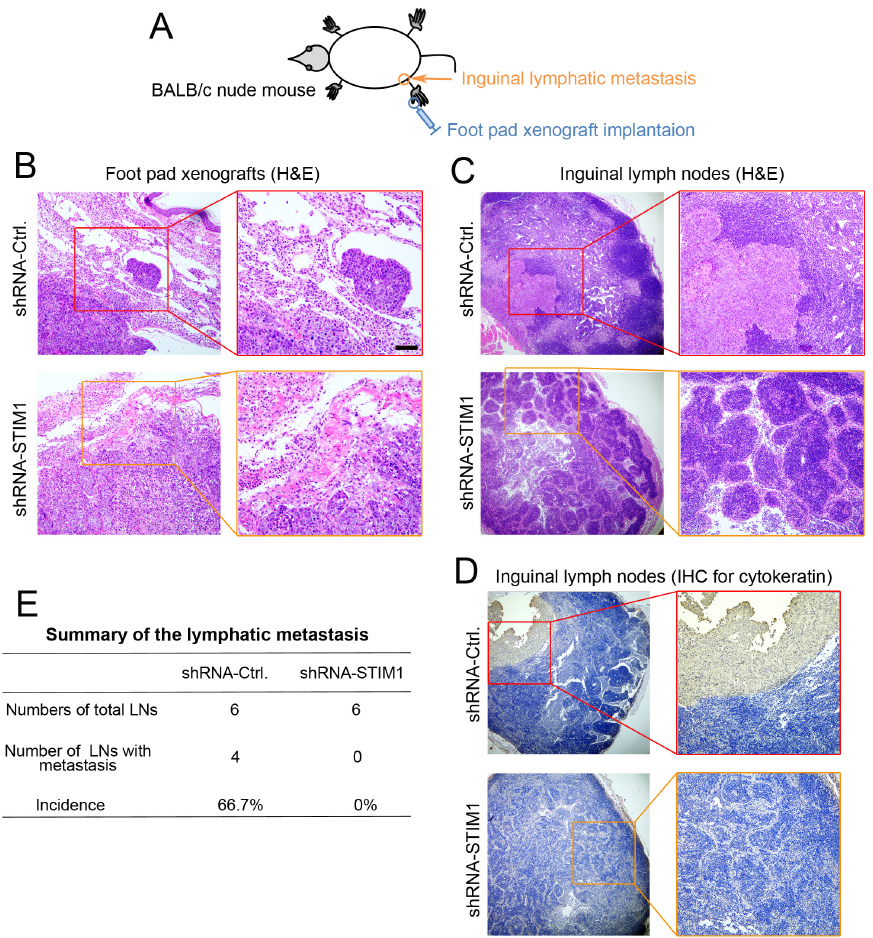
Figure 3. Knockdown of STIM1 reduces the regional lymphatic metastasis in vivo. ( A ) Schematic diagram illustrates an inguinal lymph node metastasis model of mice. ( B ) Representative photographs of H&E-stained xenograft tumors in the foot pad of shRNA-Ctrl or shRNA-STIM1 groups. The tumor emboli were observed in the surrounding vasculature in the shRNA-Ctrl group (red box). The shRNA-STIM1 group had no tumor emboli in the surrounding vasculature. Bar = 100 μ m. ( C ) H&E staining of lymph node sections from the two groups. Local-regional metastases were found in the inguinal lymph node from the shRNA-Ctrl group (red box) but none in those from the shRNA-STIM1 group. ( D ) Immunohistochemical analysis for cytokeratin was performed to confirm the epithelial origin of lymph node metastasis (red box). ( E ) Summary of the incidence of lymph node metastasis in each group ( p < 0.05, one-sided Fisher’s exact